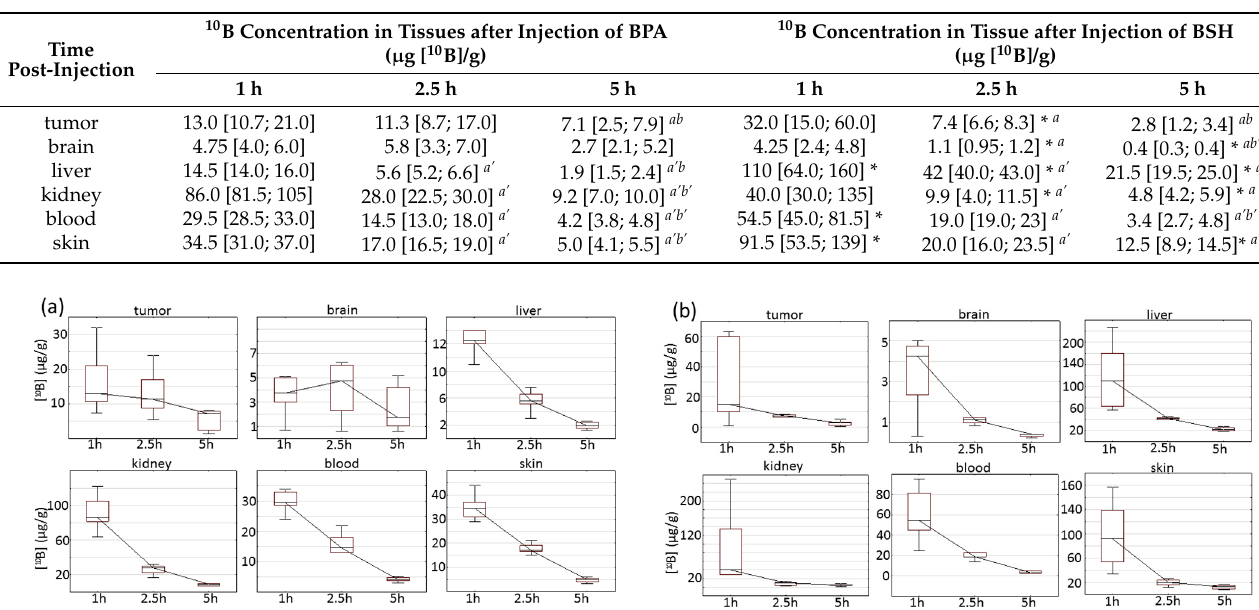
Table 1. 10 B concentration after injection of BSH or BPA for different tissues. Data are presented as median and the 25th and 75th percentiles. Significance of differences was defined by Mann–Whitney pairwise comparison followed by a Bonferroni post-test. a Statistical difference according to 1-h group with the same compound ( p < 0.05). a ’ Statistical difference according to 1-h group with the same compound ( p < 0.001). b Statistical difference according to 2.5-h group with the same compound ( p < 0.05). b’ Statistical difference according to 2.5-h group with the same compound ( p < 0.001). * Statistical difference according to BPA group at the same time points ( p < 0.05).